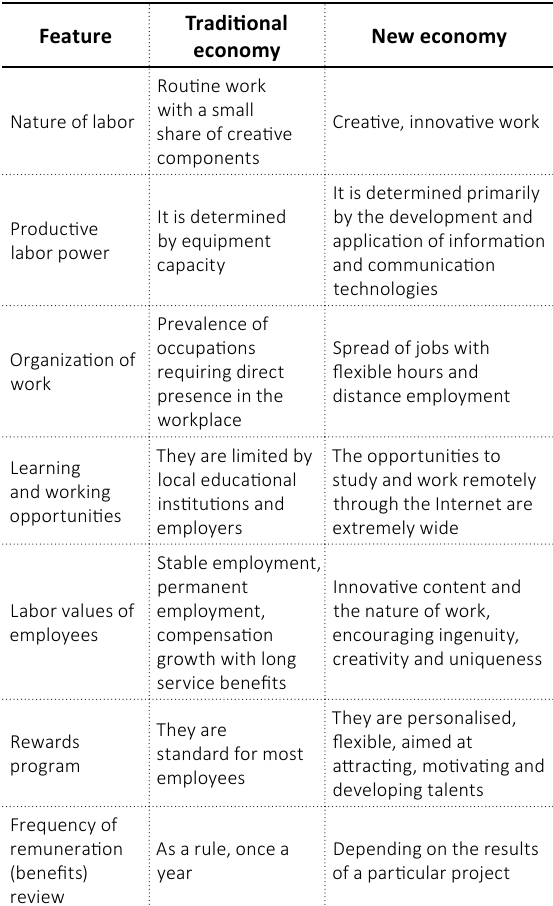
Table 1. Features of employment and organization of employee